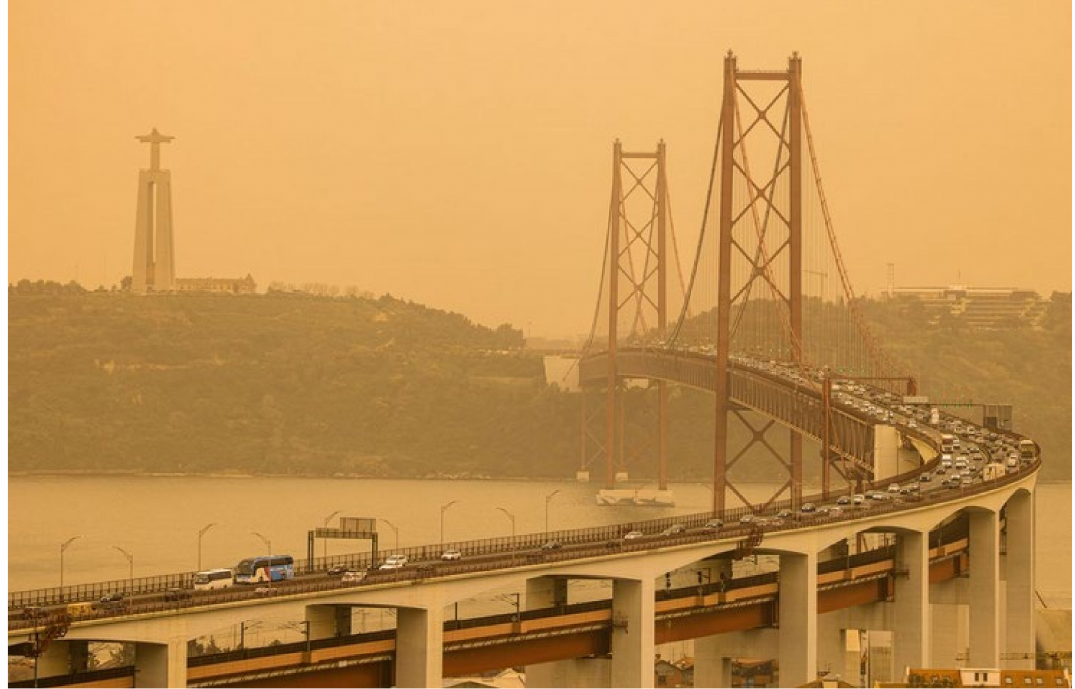
Figure 1. Overview of 25 April bridge, linking Lisbon to Almada, on 16 March 2022, where an “orange” sky can clearly be seen, around 12:00